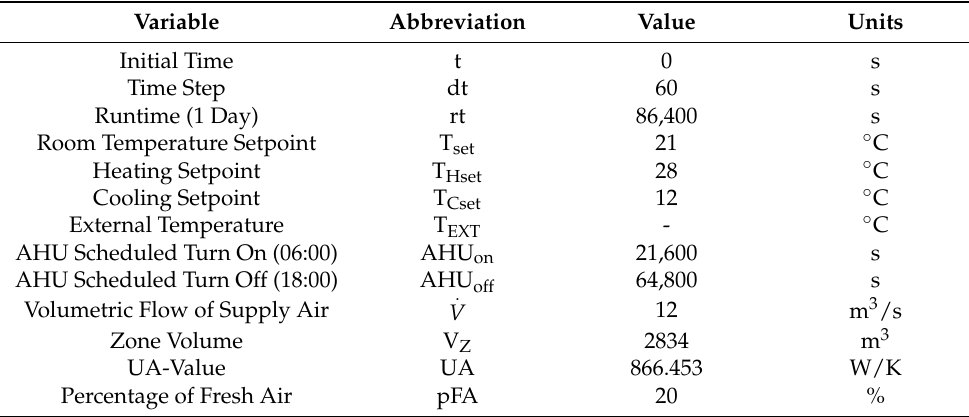
Table 1. Model inputs, operating schedules and physical